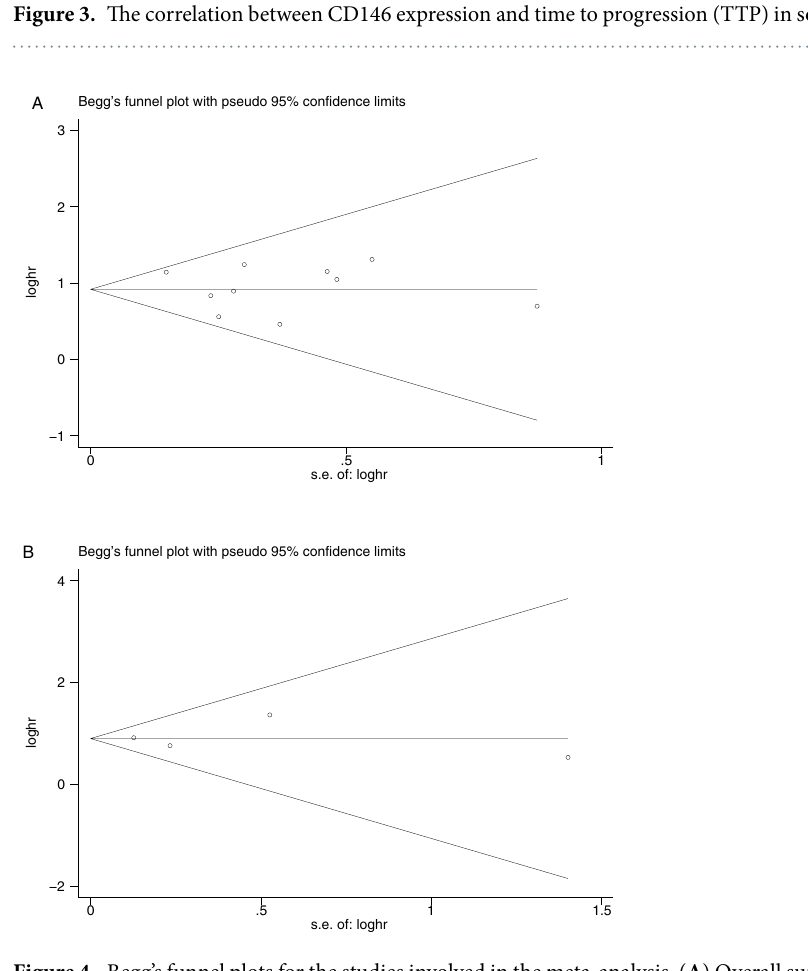
Figure 4. Begg’s funnel plots for the studies involved in the meta-analysis. ( A ) Overall survival. ( B ) Time to progression (TTP). Abbreviations: loghr, logarithm of hazard ratios; s.e., standard